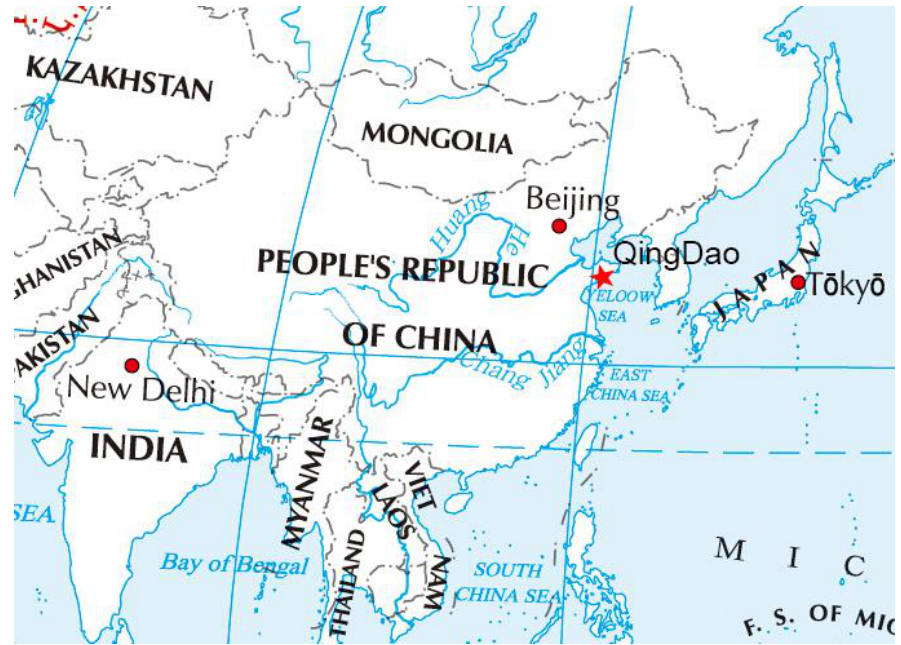
Figure 1. Location of Qingdao Meteorological Station (red star), China. The map was provided by the official website of the Ministry of Natural Resources, PRC, NO: GS